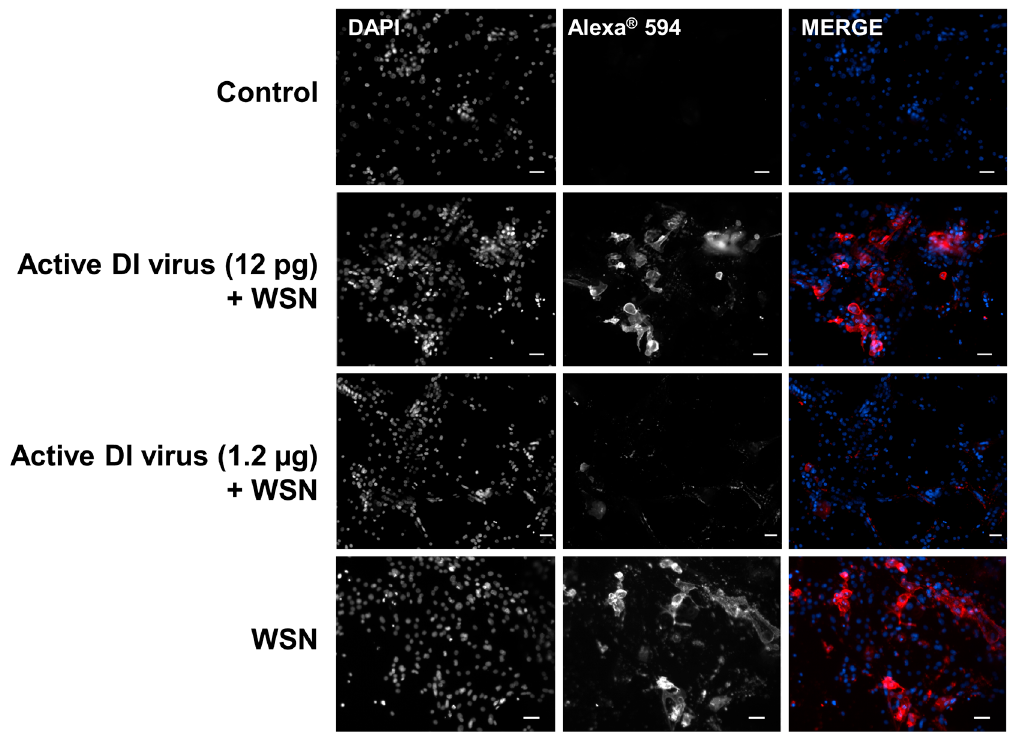
Figure 3. Immunofluorescent detection shows that 244/PR8 DI virus interferes with haemagglutinin (HA) antigen production by influenza A/WSN/33 (WSN) in primary human nasal basal cells. Basal cells were inoculated with bronchial epithelial cell growth BEGM™ medium (control), or 12 pg or 1.2 μ g DI virus, as indicated, before infection with influenza A/WSN/33 virus, or infected with WSN alone. Cells were fixed after 24 h and the WSN haemagglutinin protein detected by immunofluorescence. Left panels show cell nuclei stained with 4 ′ ,6 ‐ diamidino ‐ 2 ‐ phenylindole (DAPI), middle panels show cells stained with a WSN HA ‐ specific monoclonal antibody and a secondary antibody conjugated with Alexa ® 594 (both shown in black and white), and right panels show the merged images in colour. DAPI is blue and Alexa ® 594 is red. The images show considerable reduction of the level of influenza A/WSN/33 HA protein in the presence of the higher dose 244/PR8 DI virus. The scale bar indicates 20 μ m.